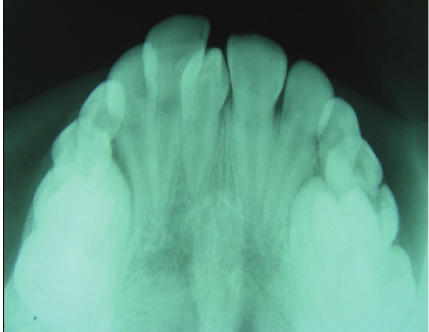
Figure 3: Bilateral unerupted (inverted) conical mesiodentes ob- served during radiographic examination of fractured anterior teeth.